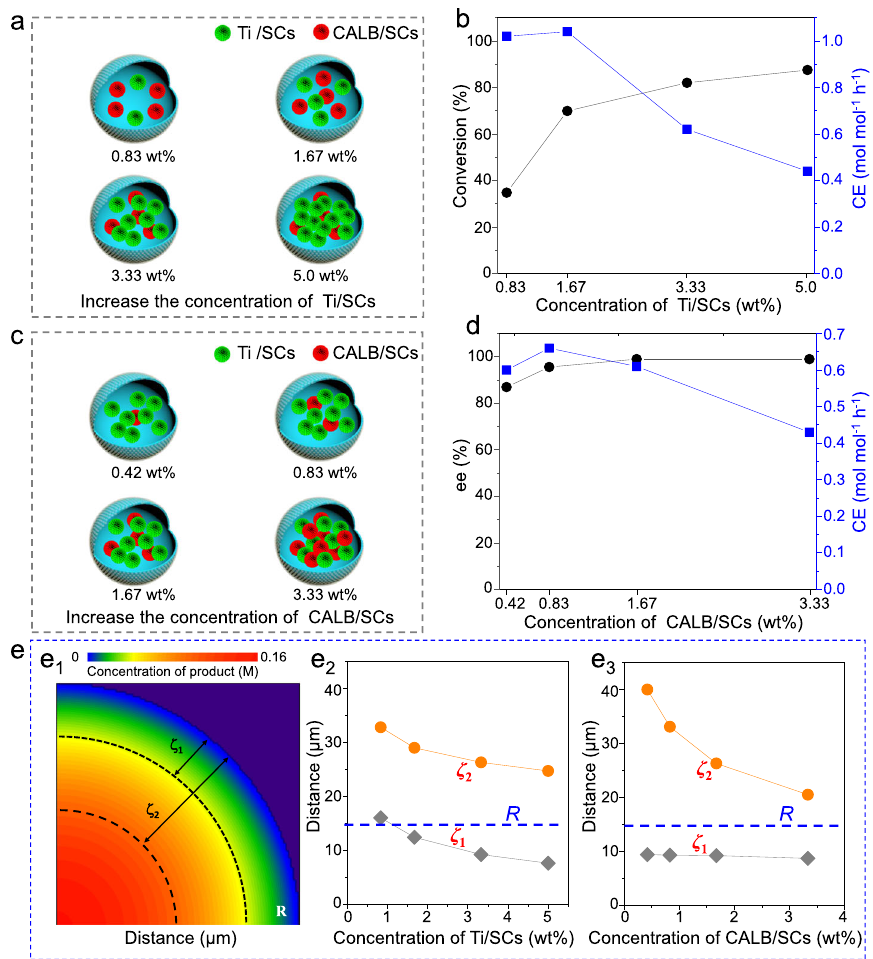
Fig. 5 Catalysis ef fi ciency for the microreactors with different catalyst ratios. a Schematic illustration of biomimetic microreactors with different fractions of Ti/SCs. b Benzaldehyde conversion and CE as a function of the fraction of Ti/SCs. c Schematic illustration of the biomimetic microreactors with different fractions of CALB/SCs. d E.e. and CE a function of the fraction of CALB/SCs. e 1 Schematic illustration of the relationship between ζ 1 , ζ 2 , and R . e 2 ζ as a function of the Ti/SCs concentration. e 3 ζ as a function of the CALB/SCs concentration. The reaction conditions are the same as those in Fig. 3c except for the ratio of